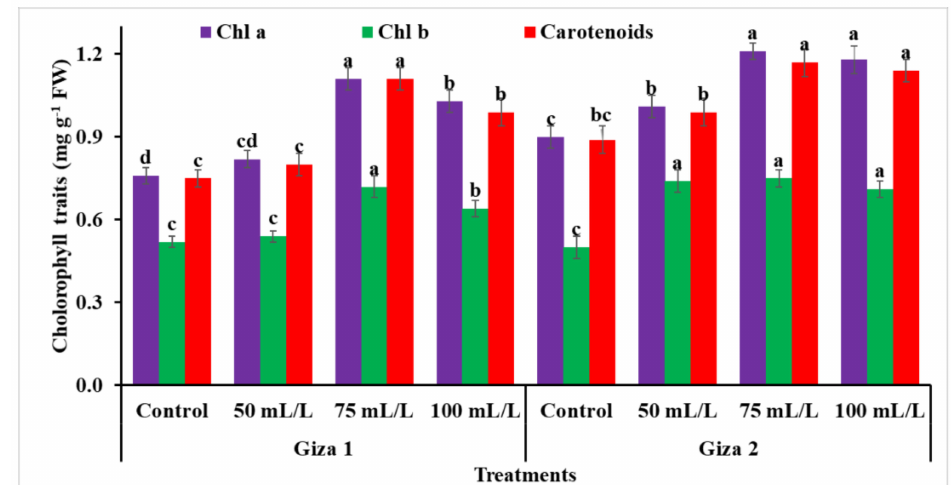
Figure 3. Effect of four AYE exogenous applications on leaf pigments of two lupine cultivars grown in reclaimed-saline soil. Chl a = Chlorophyll a; Chl b = Chlorophyll b. For each parameter, treatments followed by the same letter are not significantly differed at p ≤ 0.05. Error bars are ± Standard Error (SE).